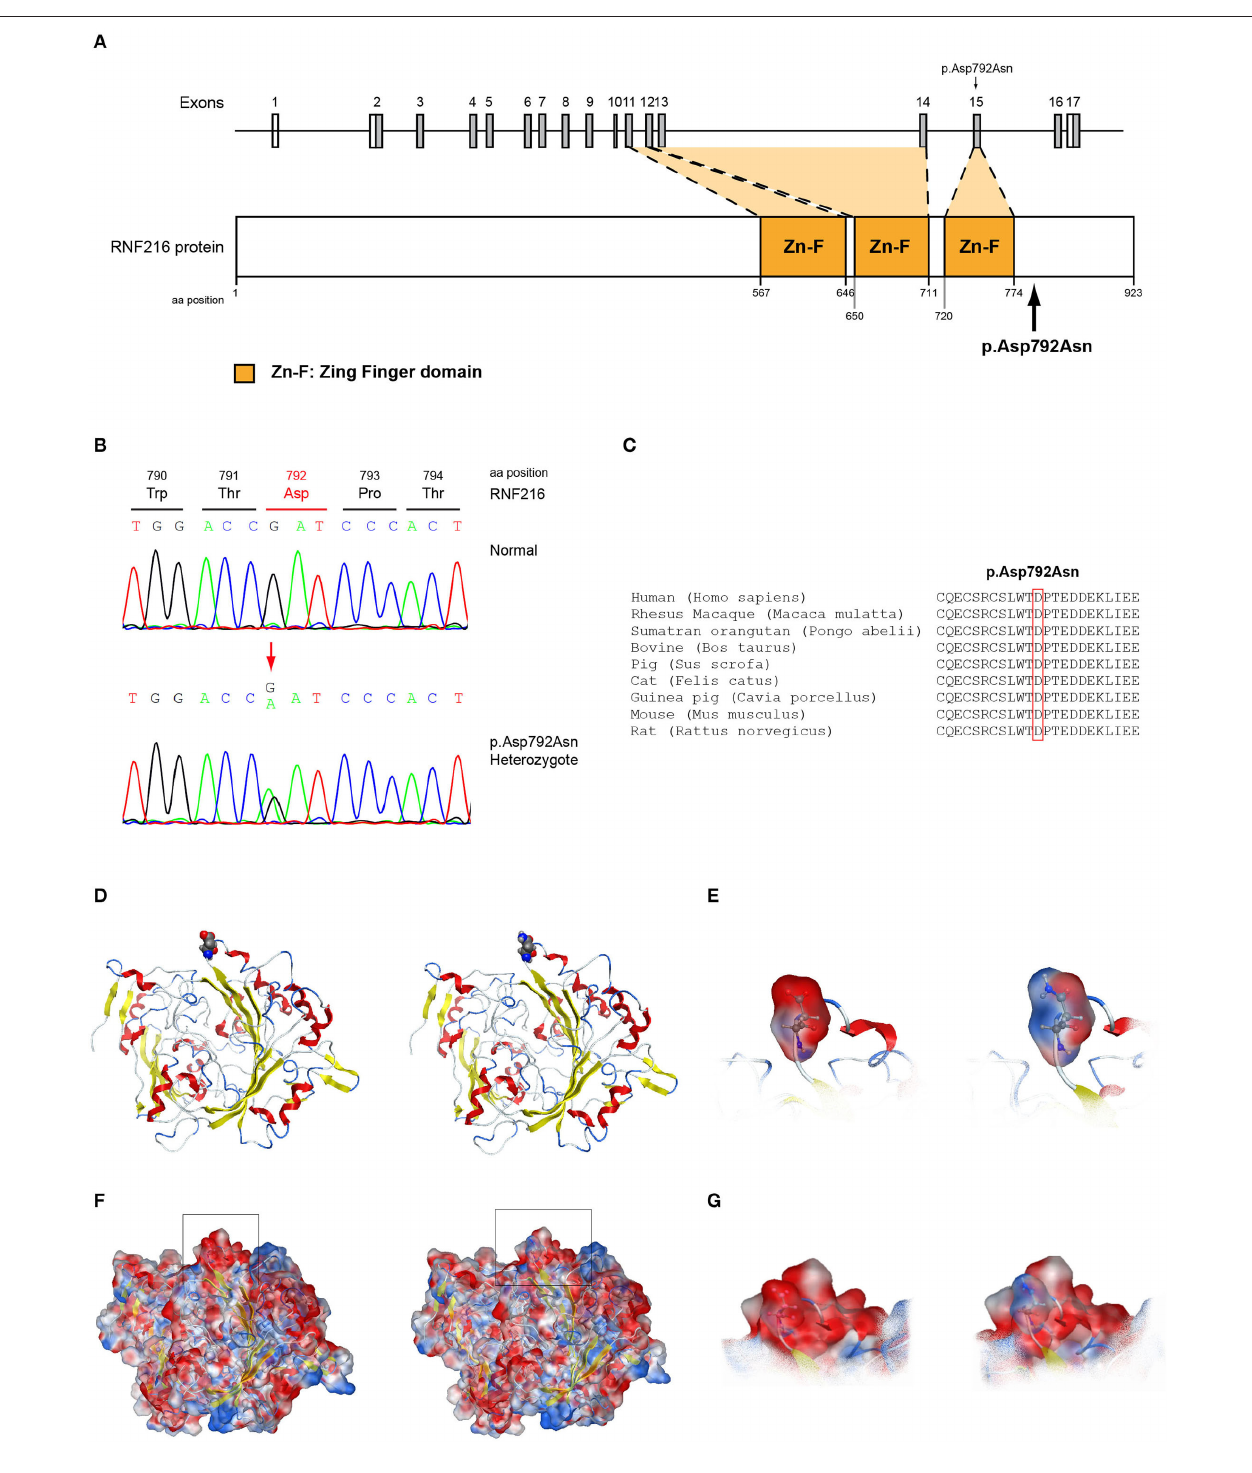
FIGURE 8 | Identification of the p.Asp792Asn RNF216 variant . (A) Schematic representation of the RNF216 gene and protein of a male patient identified with the novel p.Asp792Asn variant. (B) Sequence electropherogram of a male patient identified with the novel RNF216 p.Asp792Asn variant. (C) Multiple sequence alignment of the amino acid at position 792 of the RNF216 protein from various species. The conserved aspartic acid amino acid at position 792 is indicated by red color. (D) The p.Asp792Asn RNF216 variant is indicated with spacefill atoms. (E) The electrostatic potential surface calculated and drawn for the wild type and mutant residues at the 792 position of RNF216 . (F) The electrostatic potential surface calculated and drawn for the whole protein. In squares the regions presented in (G) . (G) The electrostatic potential surface calculated and drawn for the adjacent to the 792 position residues.